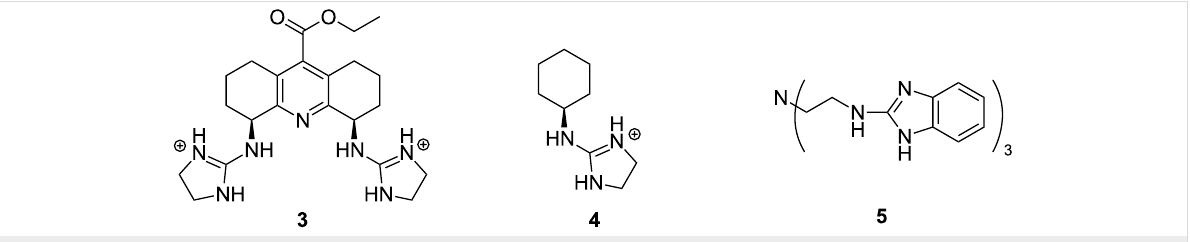
Figure 7: Guanidinium-group-based cleaving agents of RNA.